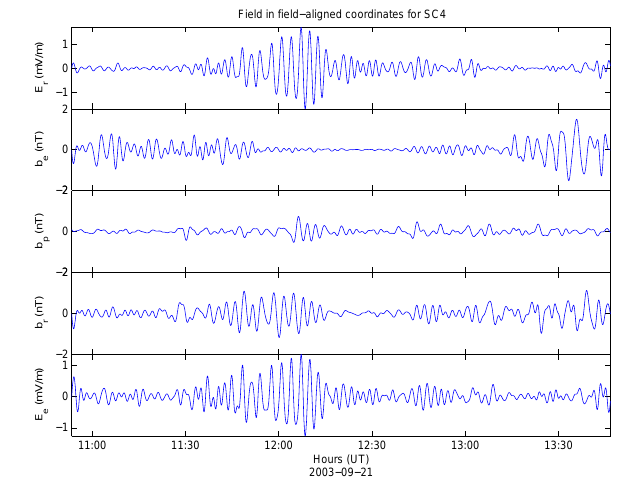
Fig. 8. The duskward electric field for the 21 September 2003 event.